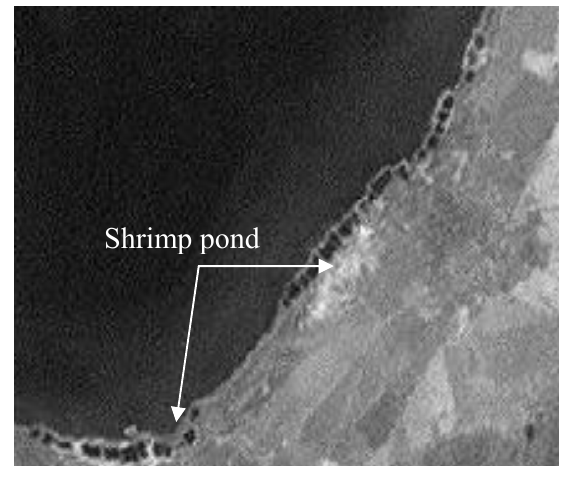
Figure 8. Shrimp ponds around Xincun Bay in 2001.